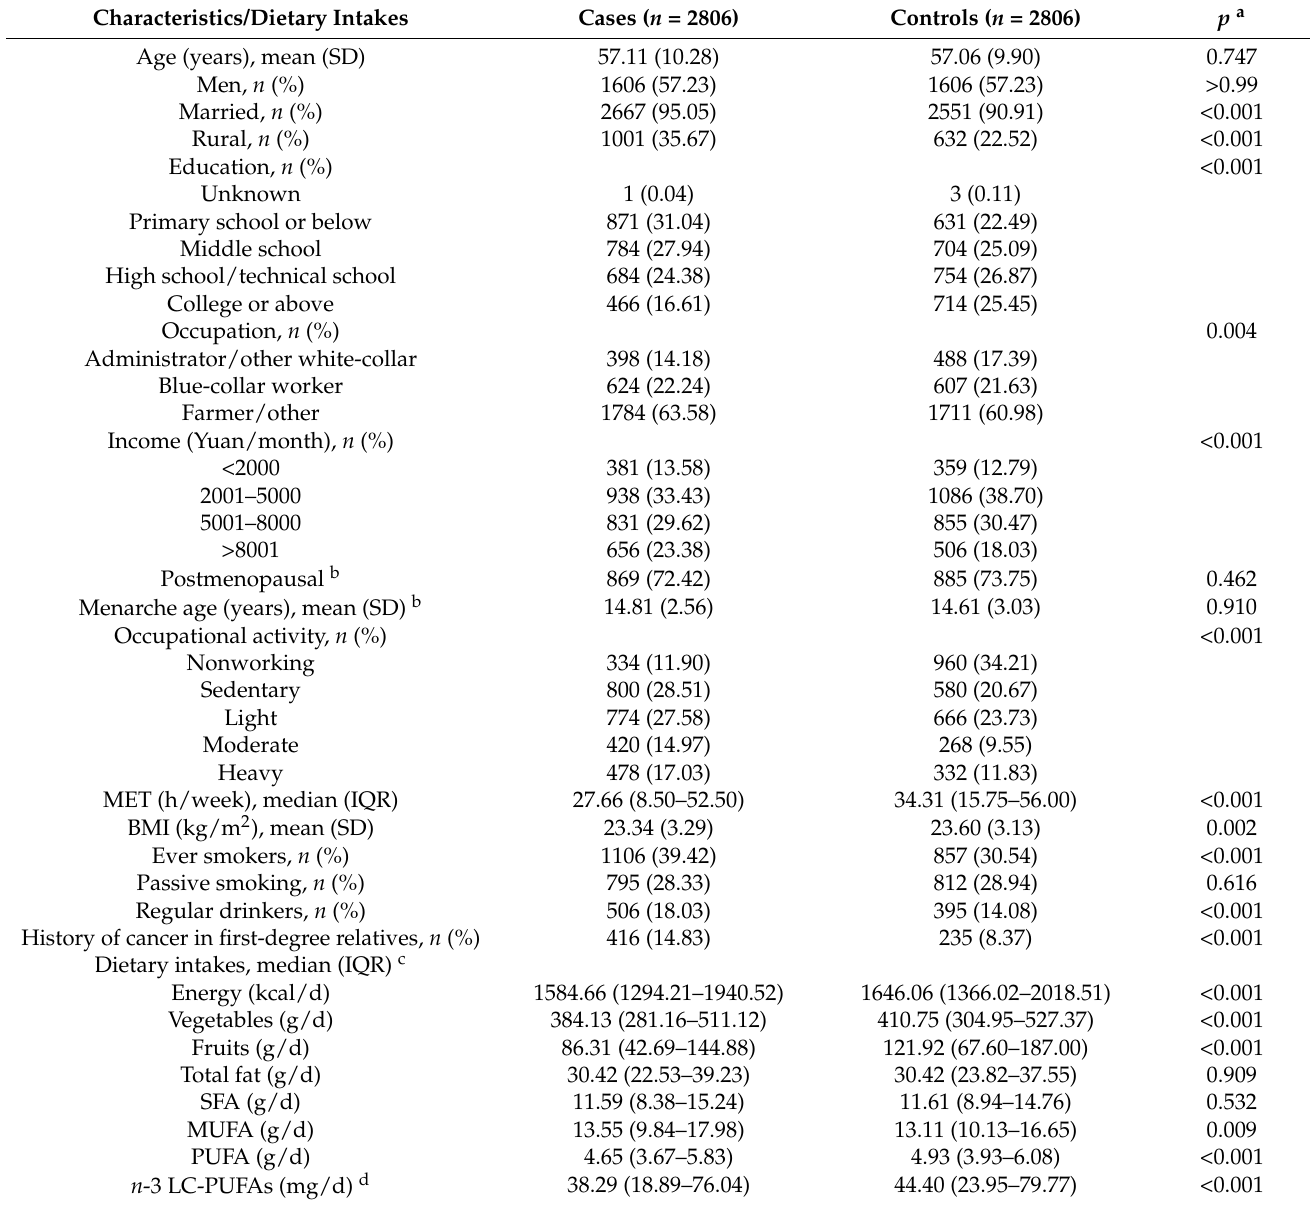
Table 1. Characteristics and dietary intakes in colorectal cancer cases and